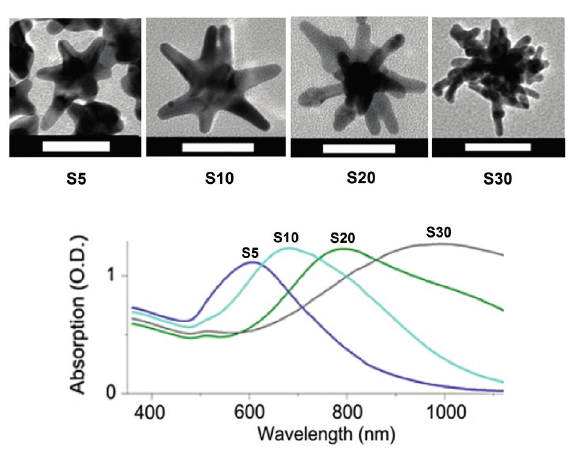
Figure 1. Top : TEM images of gold nanostars (AuNSs) formed under different Ag + concentrations via a seed-mediated method using AgNO 3 (S5: 5 µM, S10: 10 µM, S20: 20 µM, S30: 30 µM). The scale bar is 50 nm; Bottom : extinction spectra of synthesized AuNSs solutions (~0.1 nM) in water [29]. (Adapted from Ref.